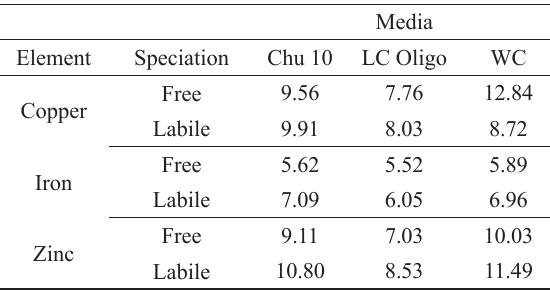
MINEQL + metal speciation results for selected elements in the growth media. Values are in pCu, pFe and pZn, where p = negative base log of the molar 10